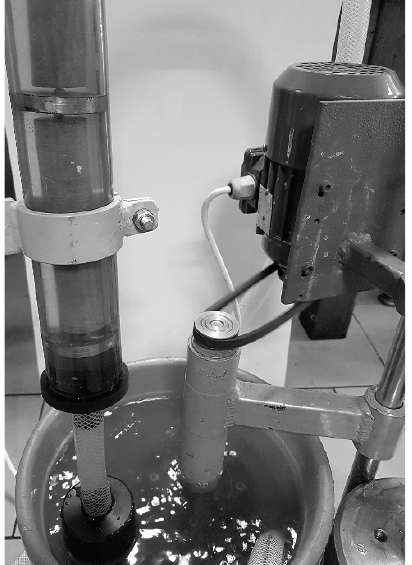
Figure 1. A photo of the drilling fluid flow simulator [27].